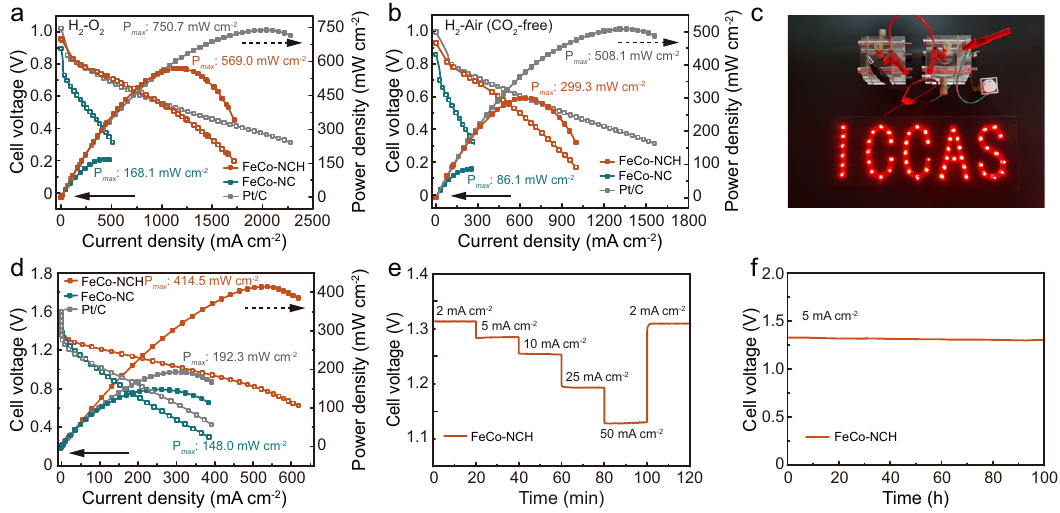
Fig. 5 | Performance of AEMFCs and Zn − air batteries. a H 2 -O 2 AEMFC perfor- manceof FeCo-NCH and control samples. b H 2 -Air (CO 2 free) AEMFCperformance ofFeCo-NCHandcontrolsamples. c OpticalimageofanLEDlightarraypoweredby two Zn − air batteries in series using FeCo-NCH as the air cathode. d Discharge polarization curves and corresponding power density curves of FeCo-NCH-based